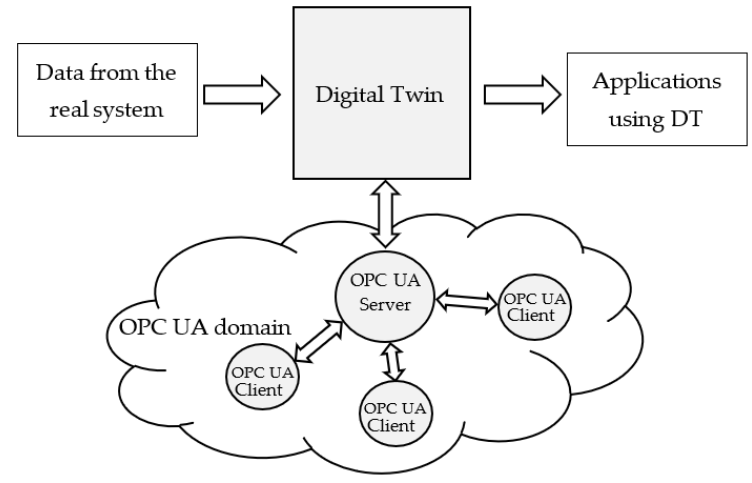
Figure 1. Graphical representation of the proposal.